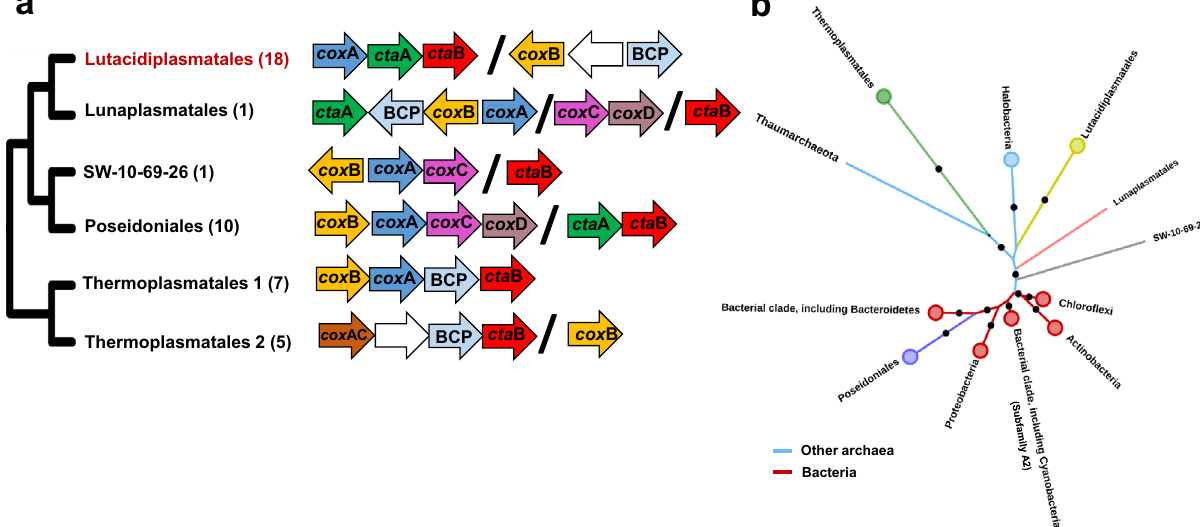
Fig. 5 Complex IV genetic organisation and phylogeny. a The physical genetic organisation of complex IV genes in Thermoplasmatota is conserved at the order level but highly variable at the phylum level. The complex IV loci in the genera Ferroplasma , Acidiplasma and Picrophilus (Thermoplasmatales 2), are different from those present in the rest of the Thermoplasmatales order (Thermoplasmatales 1). The black backslash ( / ) between genes indicate sections that are physically separated in the genome sequence, and white arrows represent hypothetical proteins. b The ML tree of the cox A subunit of haem- copper oxygen reductase shows that the Poseidoniales cox A gene clusters more closely with bacterial than other archaeal sequences, indicating an independent acquisition from a bacterial donor. Circles indicate collapsed clades. The Thaumarchaeaota, Lunaplasmatales and SW-10-69-26 branches are represented by the single genomes Cenarchaeum symbiosum A, Lunaplasmatales archaeon RBG-16-67-27 and Thermoplasmatota archaeon SW-10-69-26, respectively. Dots indicate branches with >75% UFBoot support. All analysed cox A genes are from A1 subfamily, apart from one bacterial clade belonging to A2 (labelled on the tree). The expanded cox A phylogenetic tree and trees of the genes cox B, cta A and cta B are presented in Supplementary Fig. 10 –